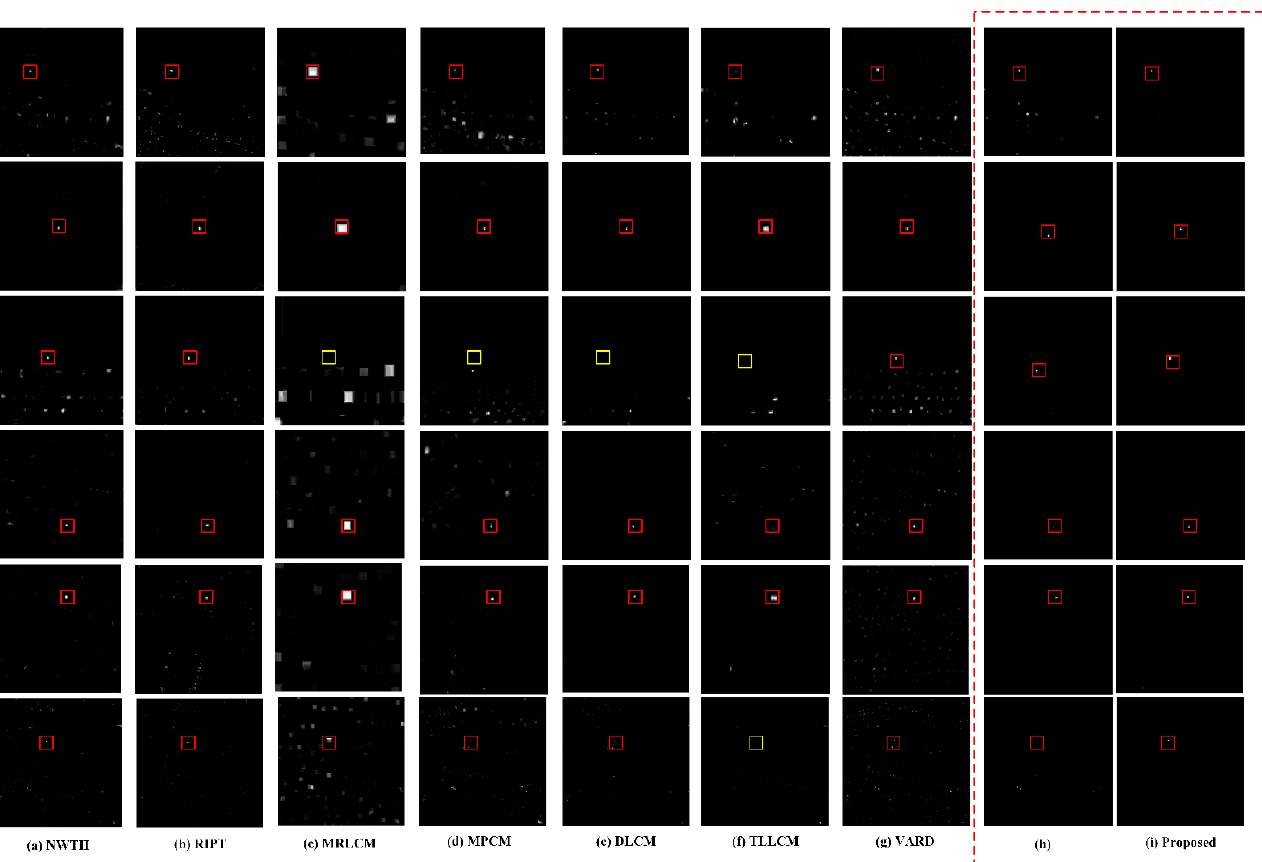
Figure 8. The six real scenes used in qualitative comparison of methods. ( a ) NWTH results. ( b ) RIPT results. ( c ) MRLCM results. ( d ) MPCM results. ( e ) DLCM results. ( f ) TLLCM results. ( g )